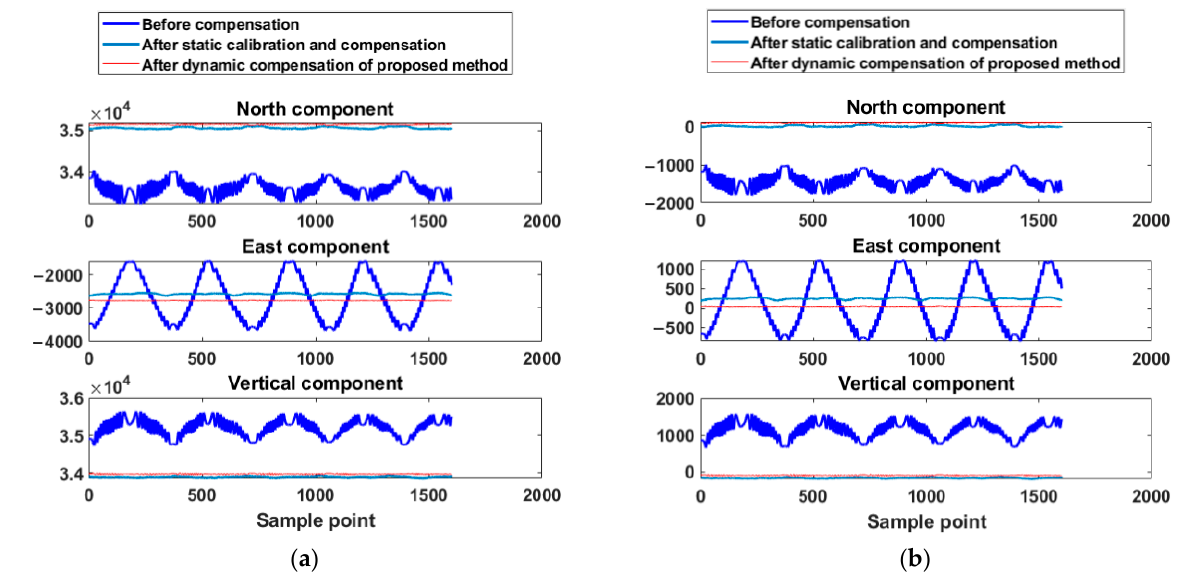
Figure 20. Dynamic measurement and static/dynamic compensation results: ( a ) results of raw data; ( b ) results of data subtracting the calibration value.